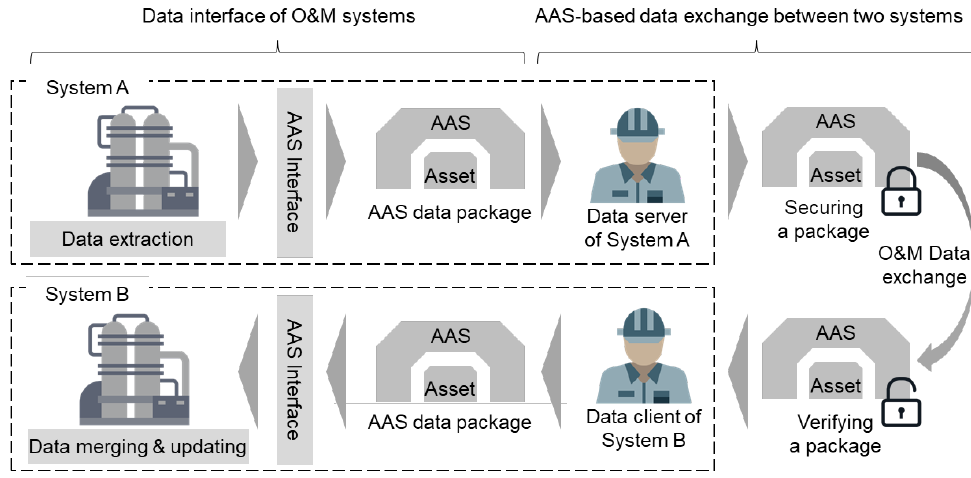
Figure 6. AAS-based data exchange between different O&M systems.